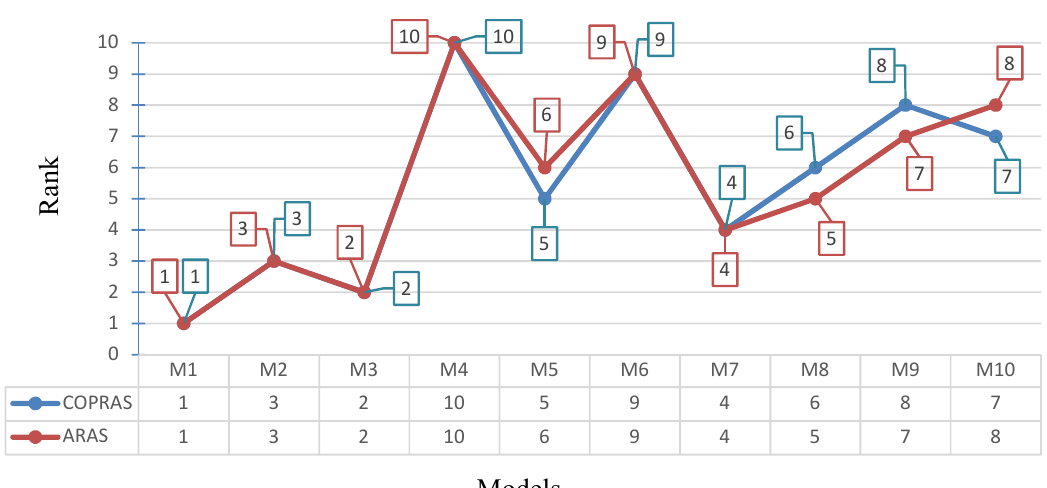
Fig. 1. Ranking Comparisons of the Mobile Models by COPRAS and